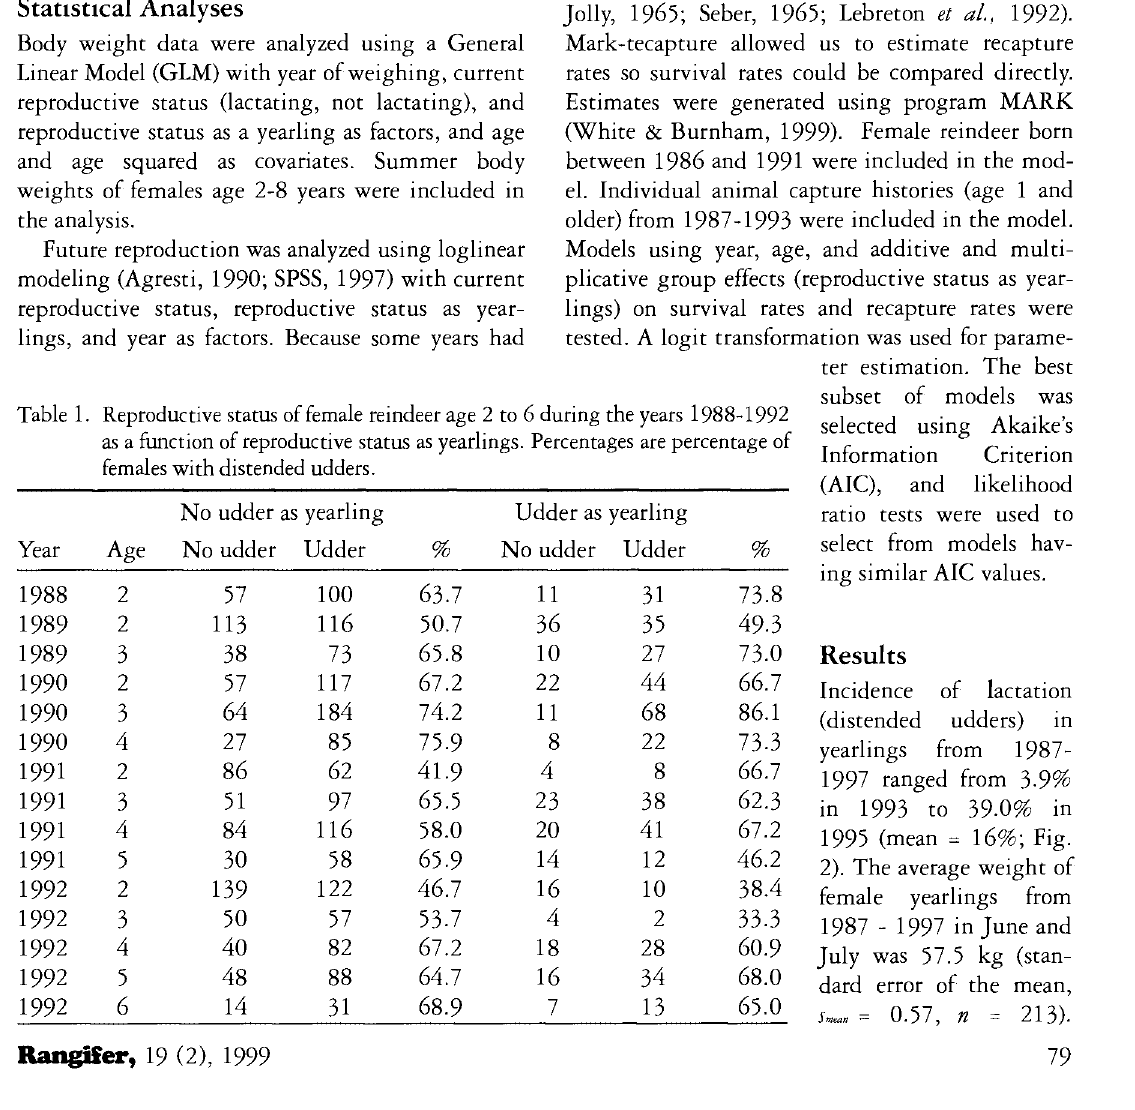
Table 1. Reproductive status of female reindeer age 2 to 6 during the years 1988-1992 as a function of reproductive status as yearlings. Percentages are percentage of females with distended